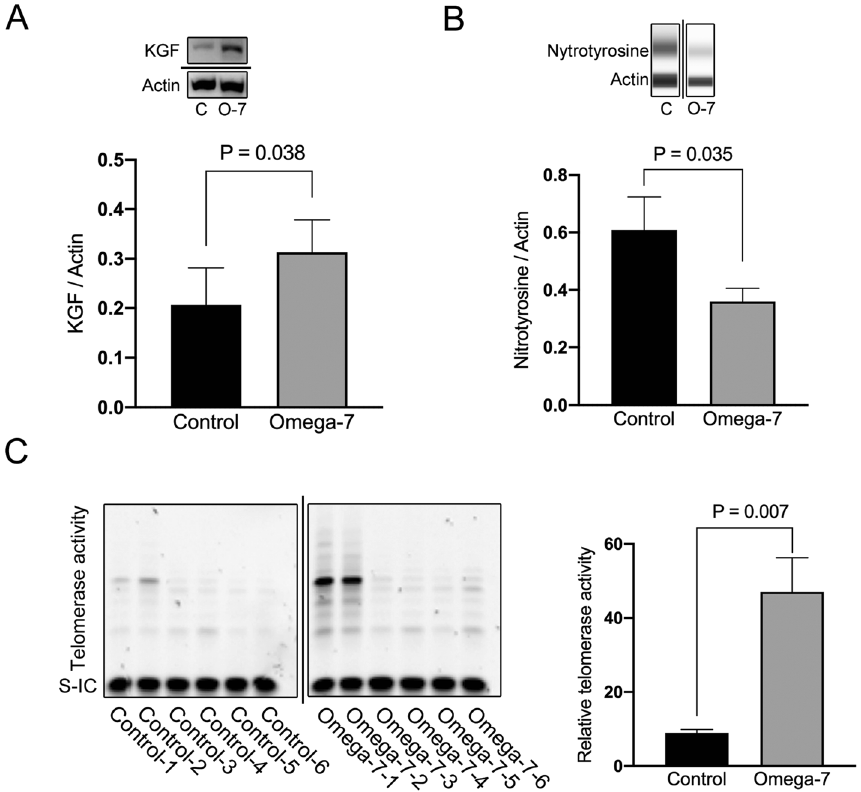
Figure 7. Keratinocyte growth factor (KGF), nitrotyrosine, and telomerase activity in grafted burn wounds at 14 days. ( A ) KGF were measured in four sheep (4 treated and 4 control sites). The level of KGF in skin tissue was significantly higher in the treatment group compared to the control group (0.21 ± 0.07 vs. 0.31 ± 0.07 relative unit). Full-length blots/gels are presented in Supplementary Fig. 1. ( B ) Nitrotyrosine were measured in eight sheep (8 treated and 8 control sites). The level of nitrotyrosine in skin tissue was significantly reduced in the treatment group compared to the control group (0.36 ± 0.05 vs. 0.61 ± 0.11 relative unit). Full-length blots/gels are presented in Supplementary Fig. 2. ( C ) Telomerase activity were measured in five sheep (6 Treated and 6 control sites). Telomerase activity measured by Telomeric Repeat Amplification Protocol (TRAP) and Gel-Based Telomerase Detection at 14 days after skin graft. The telomerase activity was significantly higher in Omega-7 grafted burn sites than that of control sites (47.1 ± 9.2 vs. 9.0 ± 0.9). The pictures show the telomerase activity of non-heat-treated samples in each group. Full-length blots/gels are presented in Supplementary Fig. 3. S-IC: signal from the internal standard in non-heat-treated samples. Data is expressed as mean ± SEM. Photographs taken and compiled, by authors, in Adobe Photoshop CC 2020 (https ://www.adobe .com/jp/produ cts/photo shop. html) without changing the content of images